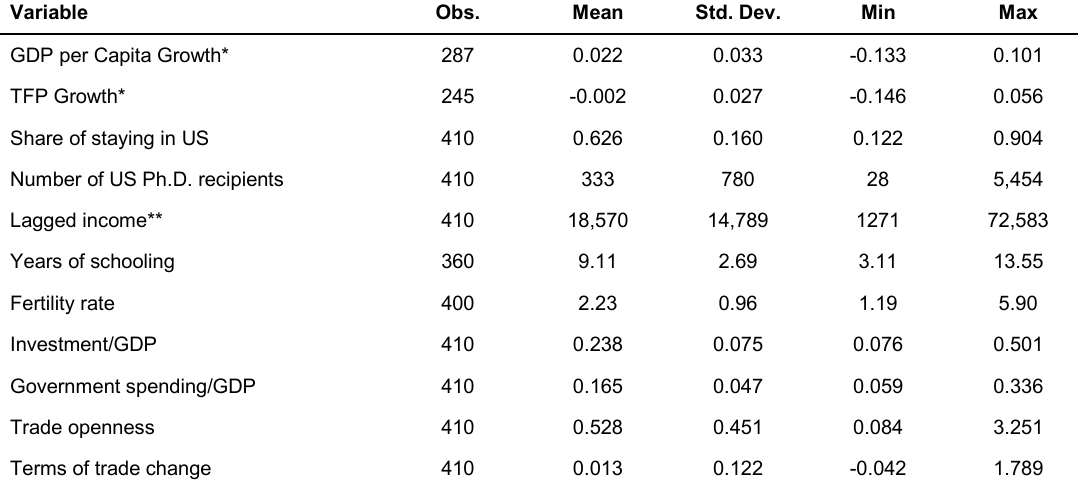
Table 6 . Summary Statistics for Models 2, 3, 5, and 6 (2008~2017, 41 Countries)